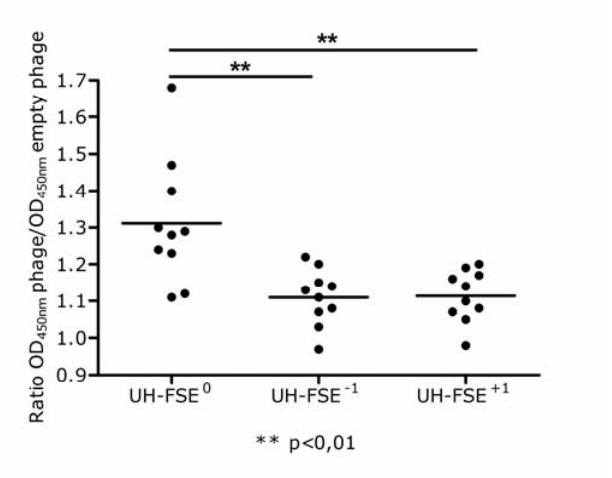
Figure 5. Detection of ApoE-immunoreactivity in the plasma of MS patients. Immunoreactivity towards the different UH-FSE phages was measured in the individual plasma of 10 MS patients that were used for the selection rounds. UH-FSE 0 displays the ApoE protein in the correct reading frame. UH-FSE − 1 and UH-FSE +1 represent respectively a − 1 and +1 shift in the reading frame of ApoE. Background values were determined by measuring reactivity towards an empty phage not displaying any protein. Results are given as a ratio of the OD phage/OD empty 450nm